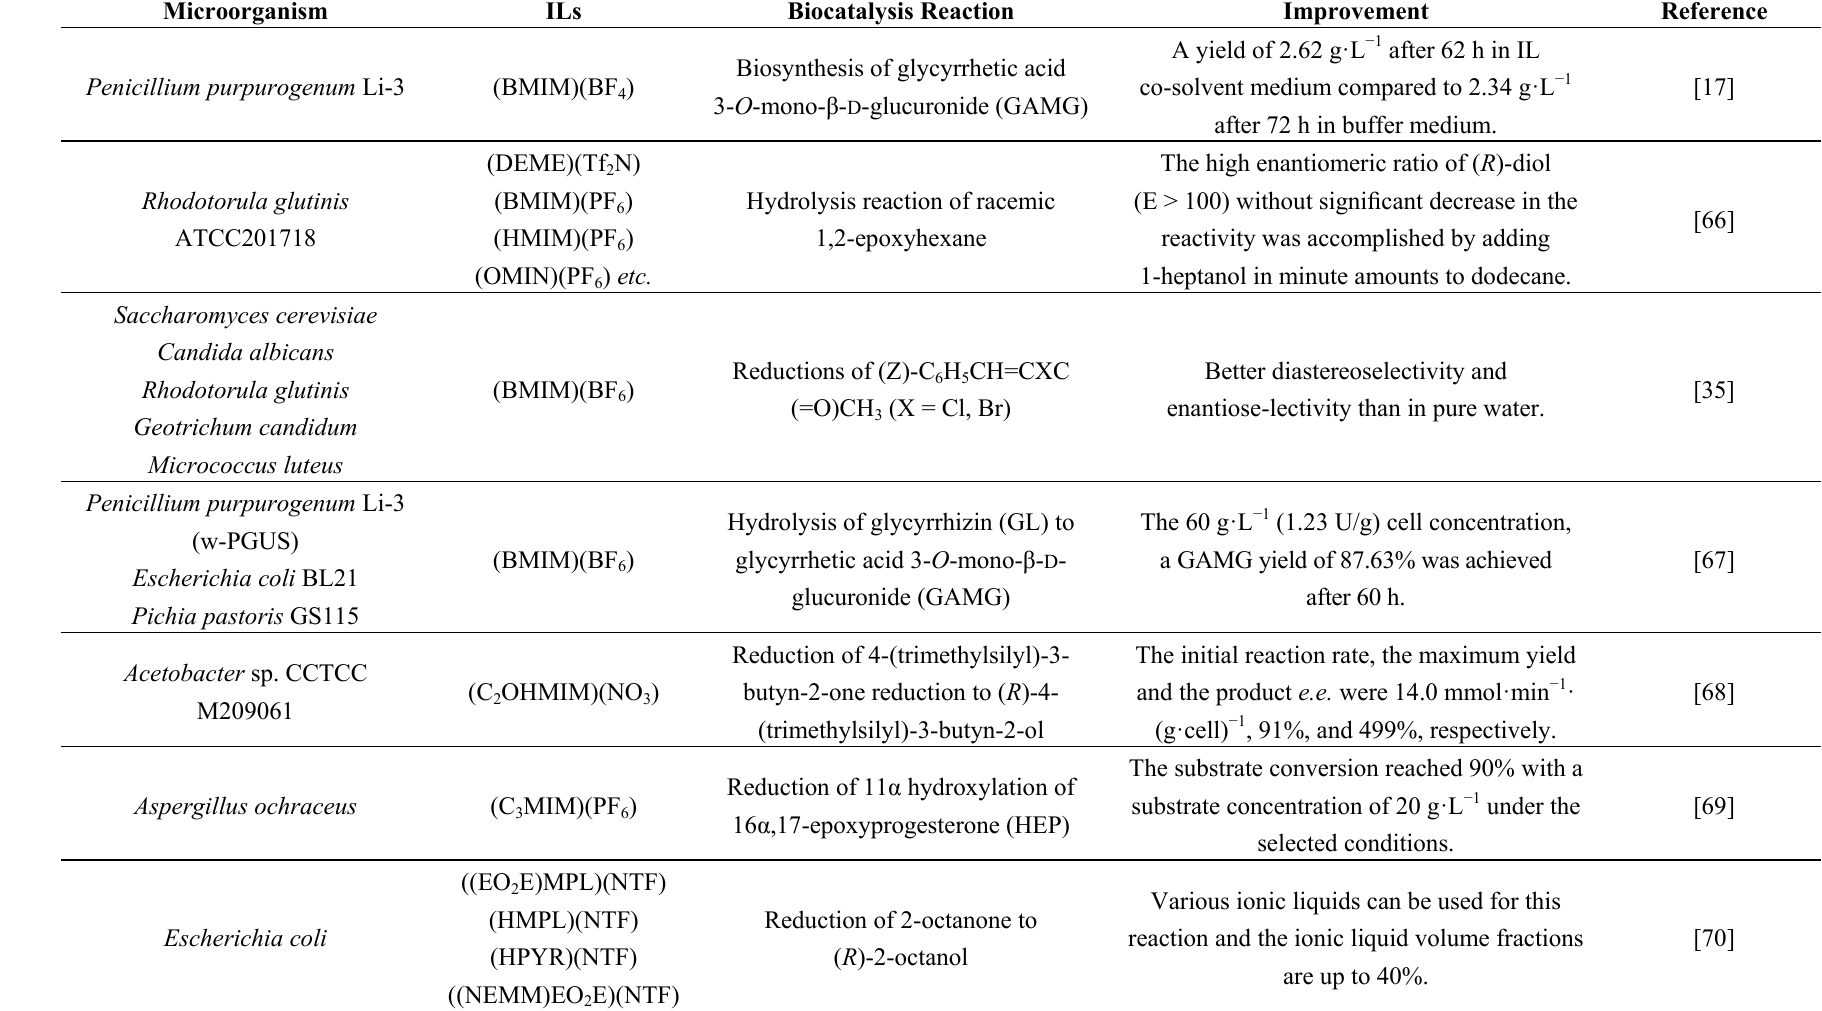
Table 1. Examples of applications of ILs in whole-cell biotransformations. Biocatalysis Reaction Improvement